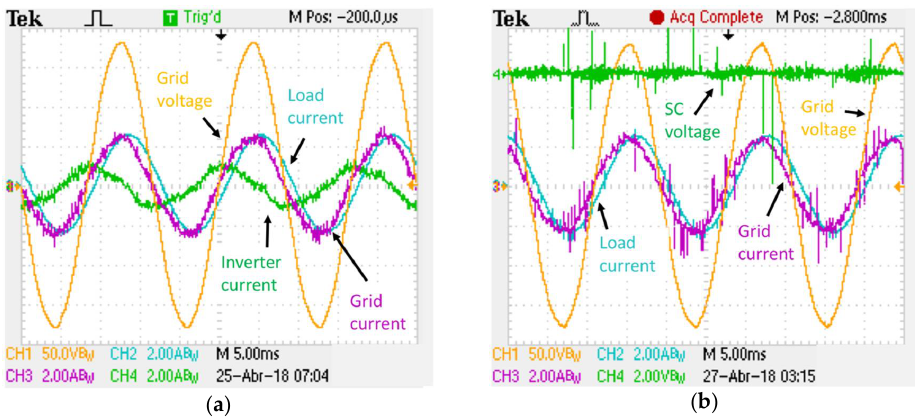
Figure 15. Experimental results of the startup response of the inverter without power generation of PV array. ( a ) Current waves of I AC , V AC I Ld , and i L ; ( b ) Current waves and V SC